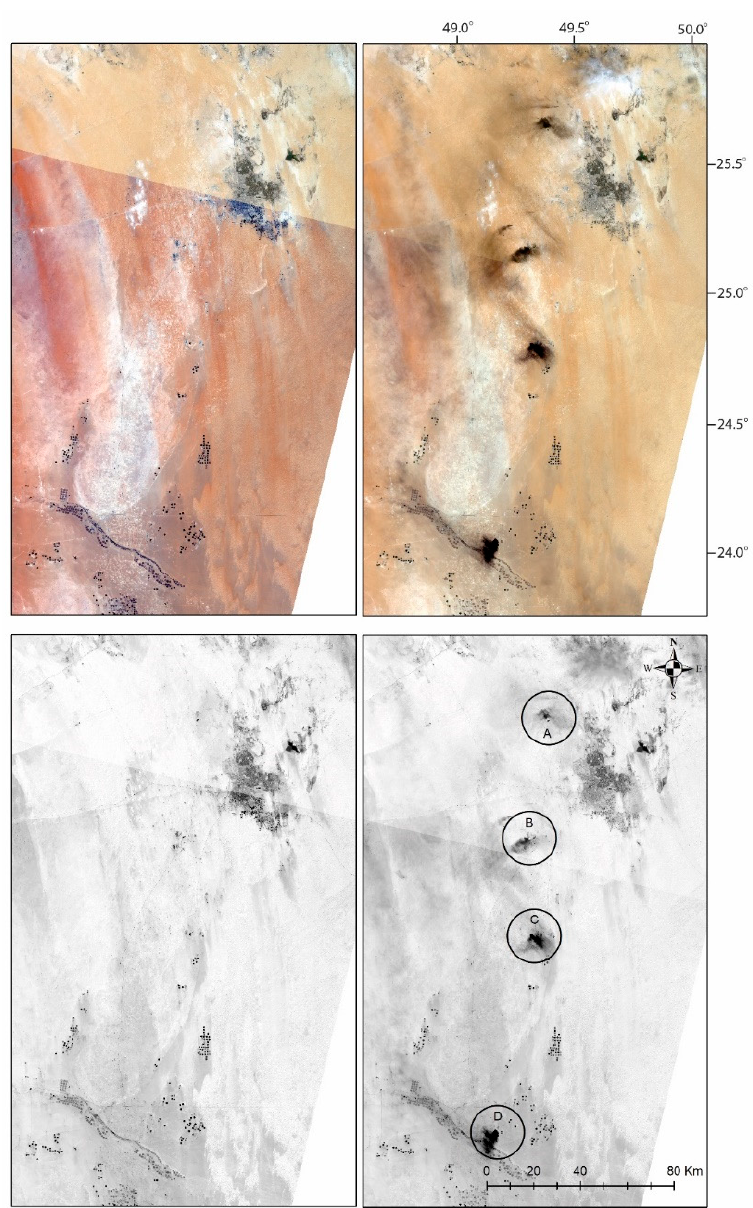
Figure 1. Landsat 8 True color (0.65 µ m band 4 as Red, 0.56 µ m band 3 as Green and 0.48 µ m band 2 as Blue) acquisition over the four ( A – D ) Saudi Arabia flares before (1st September 2019 top left) and after (17th September 2019 top right) the reported emergency flaring on 14th September 2019 are illustrated. The Landsat 2.2 μ m band 7 reflectance before and after are also illustrated (bottom images). Thick, black smoke is evident in the images of 17th September 2019 in both visual and SWIR wavelengths.